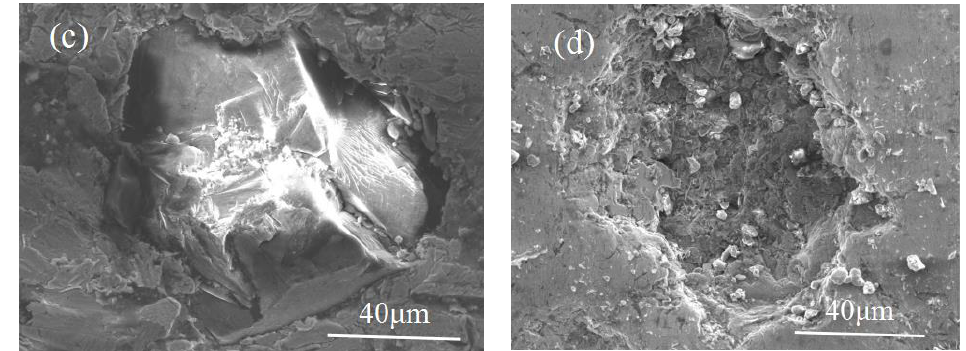
Figure 10. Wear characteristics of diamonds brazed by Cu-based alloy without containing Ce ( a ) Integrity; ( b ) micro-fracture; ( c ) fracture; ( d ) pull-out.